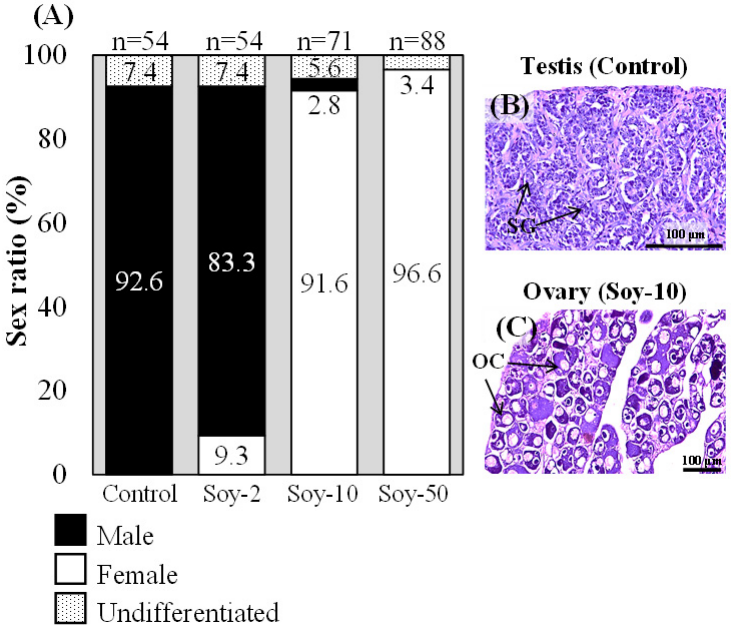
Figure 1. Feminization effects of soy isoflavones in Japanese eels. ( A ) Sex ratios in Japanese eels treated with 2, 10, or 50 g/kg diet of soy isoflavones (Soy). Control, normal diet with no soy isoflavone treatment. ( B , C ) Histological sections of gonads after hematoxylin and eosin staining: control eel testis ( B ) and isoflavone-treated eel ovary ( C ). SG, spermatogonium; OC, oocyte.